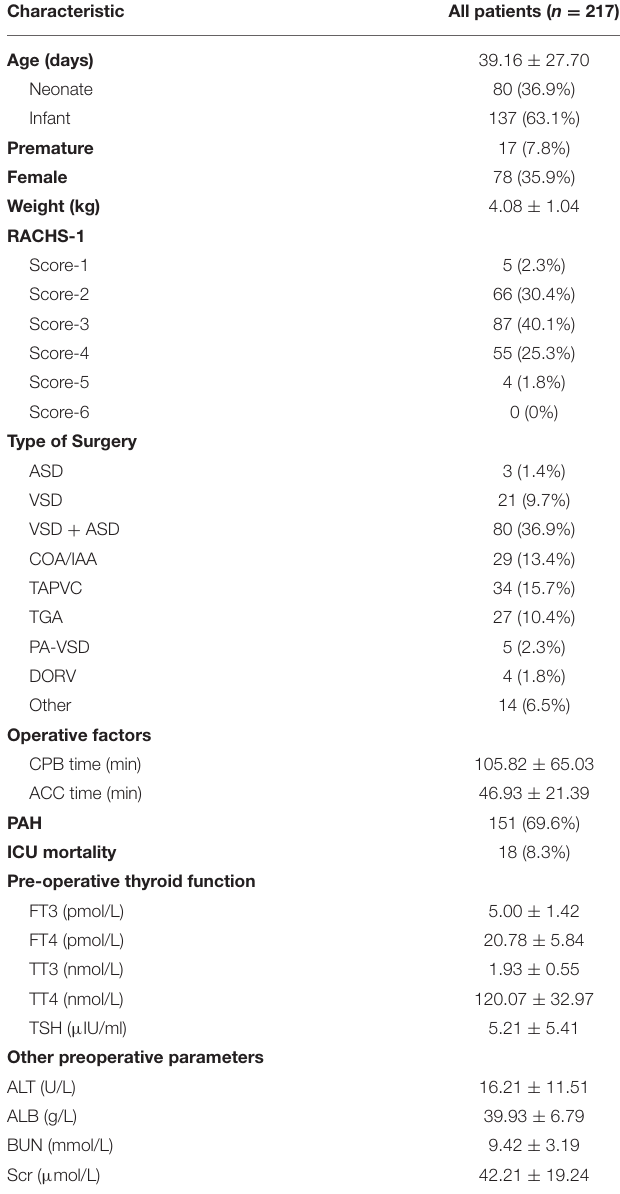
TABLE 2 | Characteristics of patients according to LCOS group and non-LCOS group.